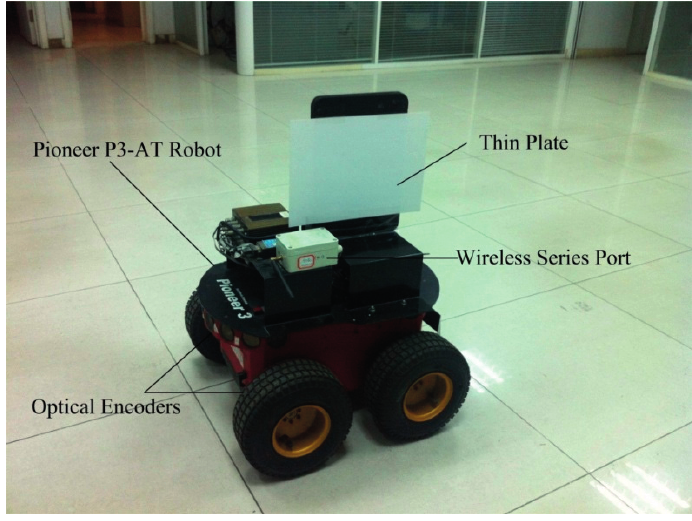
Figure 6. Skid-steering mobile robot platform—a Pioneer P3-AT mobile